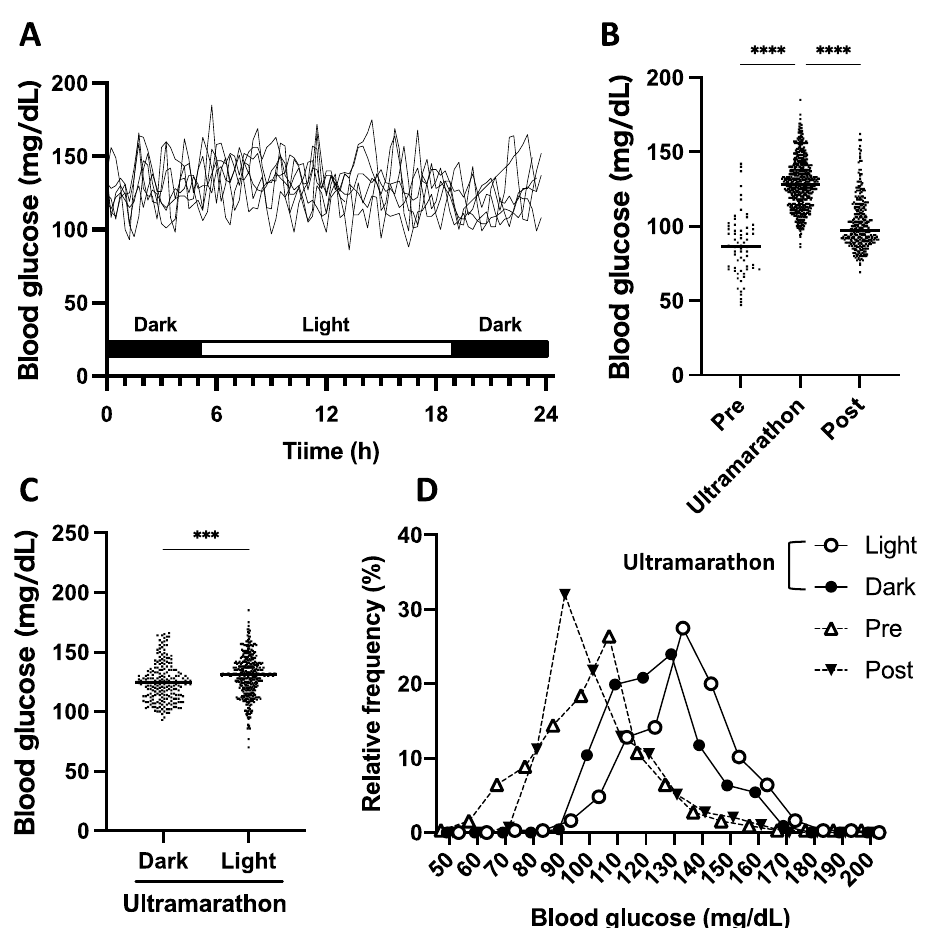
Figure 1. Blood glucose fluctuation during the 7-day ultramarathon. Each solid line represents the daily glucose variation ( A ). Scatter plot of blood glucose during a preliminary, ultramarathon, and post-ultramarathon periods, respectively ( B ). Scatter plot of blood glucose levels during night (dark) and day (light) throughout the ultramarathon ( C ). Histogram of blood glucose fluctuation during preliminary, ultramarathon (night and day), and post-ultramarathon periods ( D ). *** p < 0.001, **** p < 0.0001 The differences between dark and light were compared by the Mann–Whitney test, and those among pre, ultramarathon post were compared by the Kruskal–Wallis nonparametric ANOVA, followed by Dunn’s multiple comparison test.